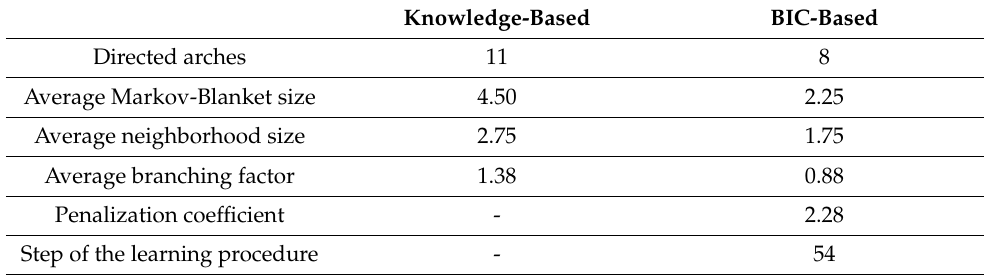
Figure 2. Bayesian network analysis. Hypothesized model (knowledge-based DAG) ( A ) and auto- matically learned model with imposed constraints (e.g., cancer and MTX) (BIC-based DAG) ( B ). The BIC-based DAG is obtained through logical and clinical associations and by selecting the model (DAG) with the best (i.e., lowest) BIC. Legend: DAG: directed acyclic graphic; BIC: Bayesian Information Criterion. Abbreviations: BMI, body mass index; MTX, metastasis; ALB, albumin; NUTR, nutri- tional support; BTcP, breakthrough cancer pain; RADIO, radiotherapy; HRA, hospital readmission. (** = p < 0.05; * = p < 0.10; • = Not Significant). Table 4. Main indicators of the proposed